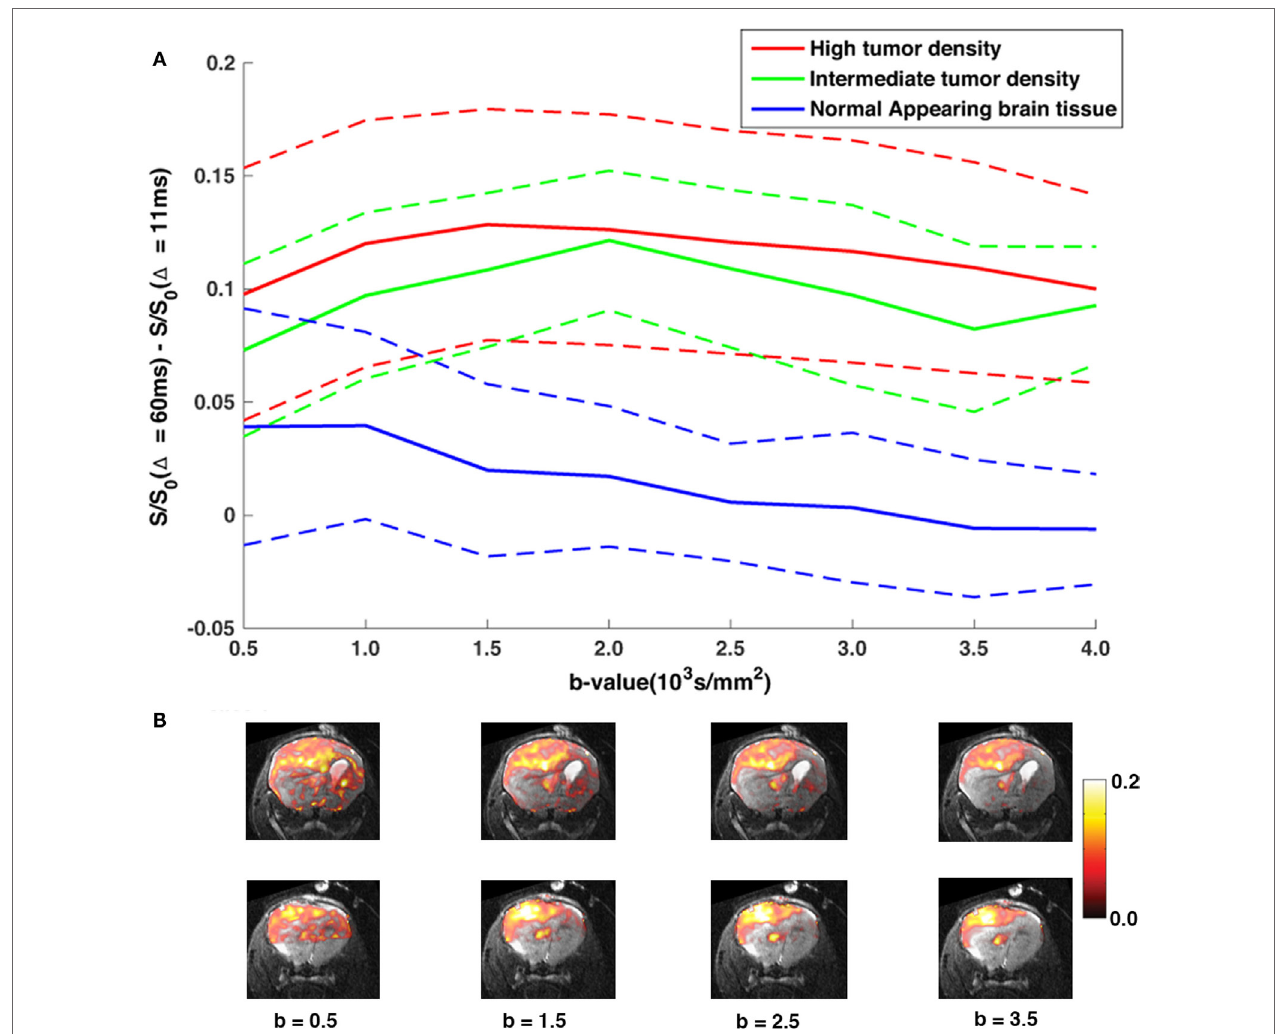
FigUre 3 | The DTD contrast with increasing b -value . (a) The average DTD contrast (solid lines) as a function of b -value for each ROI, averaged across both MR slices, with corresponding SD (dashed lines) (B) DTD-maps overlaid T 2,high images of two MRI slices analyzed in the study as a function of b -value. As predicted, the contrast between the NAB regions and tumor regions is weighted by the amount of restricted diffusion in the diffusion signal, and our results show that, at b > 1500 s/mm 2 , tumor tissue signal is well separated from the NAB signal and remains constant with increasing diffusion weighing, even within regions with lower tumor cell